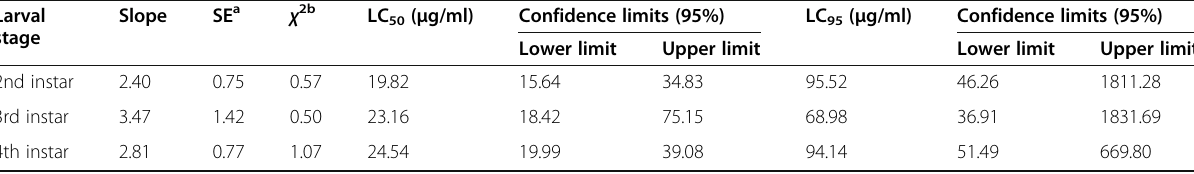
Table 3 Toxicity of 4G1 to 2nd, 3rd and 4th larval instars of tomato pinworm Tuta absoluta Larval stage